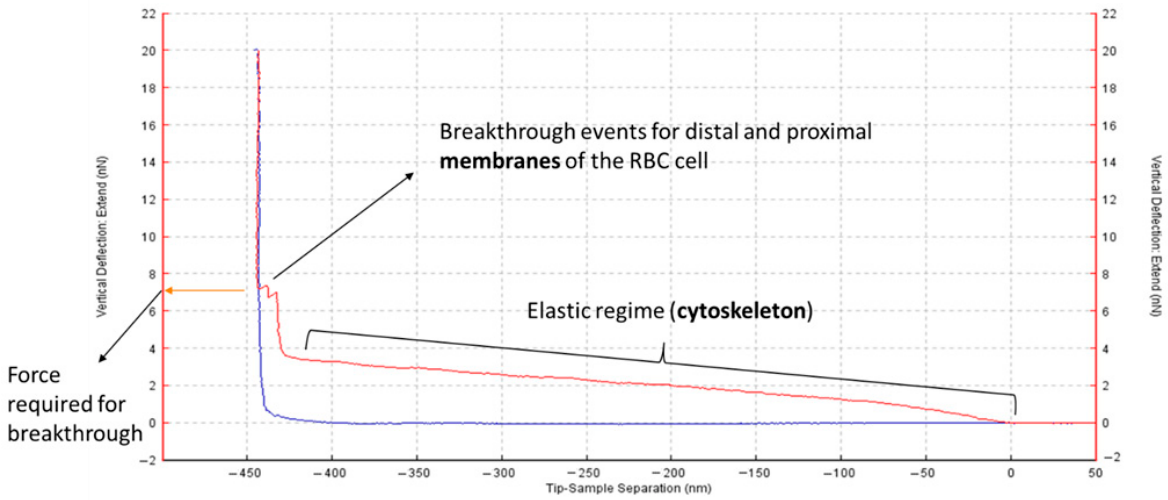
Figure 1. Representative AFM force – distance curve of an RBC. The AFM tip performs an indentation process on a supported RBC, initiated from X = 0 along the red line (trace), up to the maximum force (20 nN in this case), and coming back to the initial position long the blue line (retrace). The trace line has three distinct phases: (i) first, an elastic deformation of the cell occurs (the force required for this process depends on the cell cytoskeleton); (ii) then, after further compression, the AFM tip pierces immediately through both RBC membranes (distal and proximal); and (iii) finally the tip achieves maximum force against the support, without further X-axis displacement. Membrane rupture is achieved at a definite force, marked by the sudden appearance of small peaks, at a Y-axis value that can be statistically quantitated (performing 50 – 75 curves for each sample). These experiments were performed at room temperature.